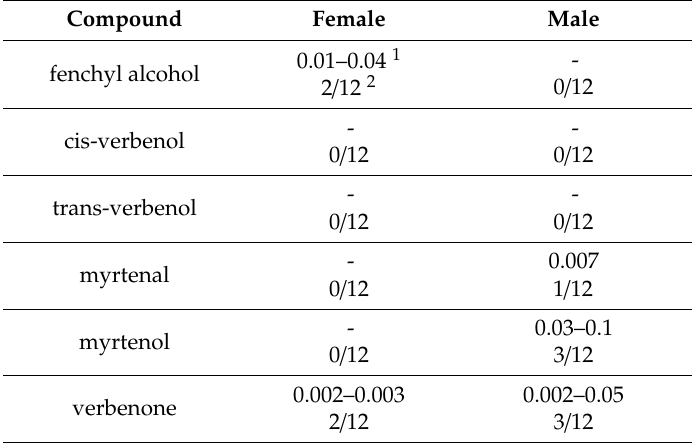
Table 3. The range of oxygenated monoterpenes quantities (ng / beetle) extracted from the gut of pre-emerged unfed D . rhizophagus